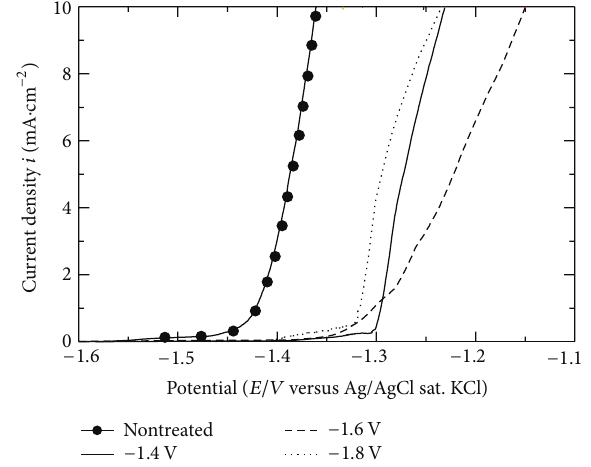
Figure 3: Anodic polarization test in PBS( − ) for AZ31 magnesium alloys before and after treatment at − 1.4V, − 1.6V, and − 1.8V.